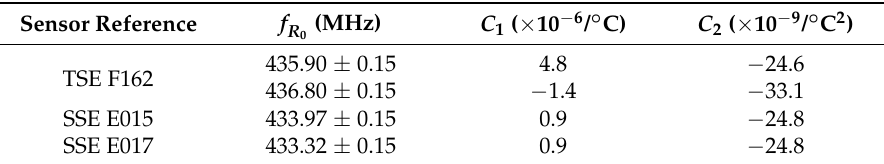
Table 1. Resonant frequencies at 25 °C, first and second order temperature coefficients of each resonator of TSE F162 temperature sensor and of SSE E015 and SSE E017 strain gages. Values taken from the sensors’ datasheets.